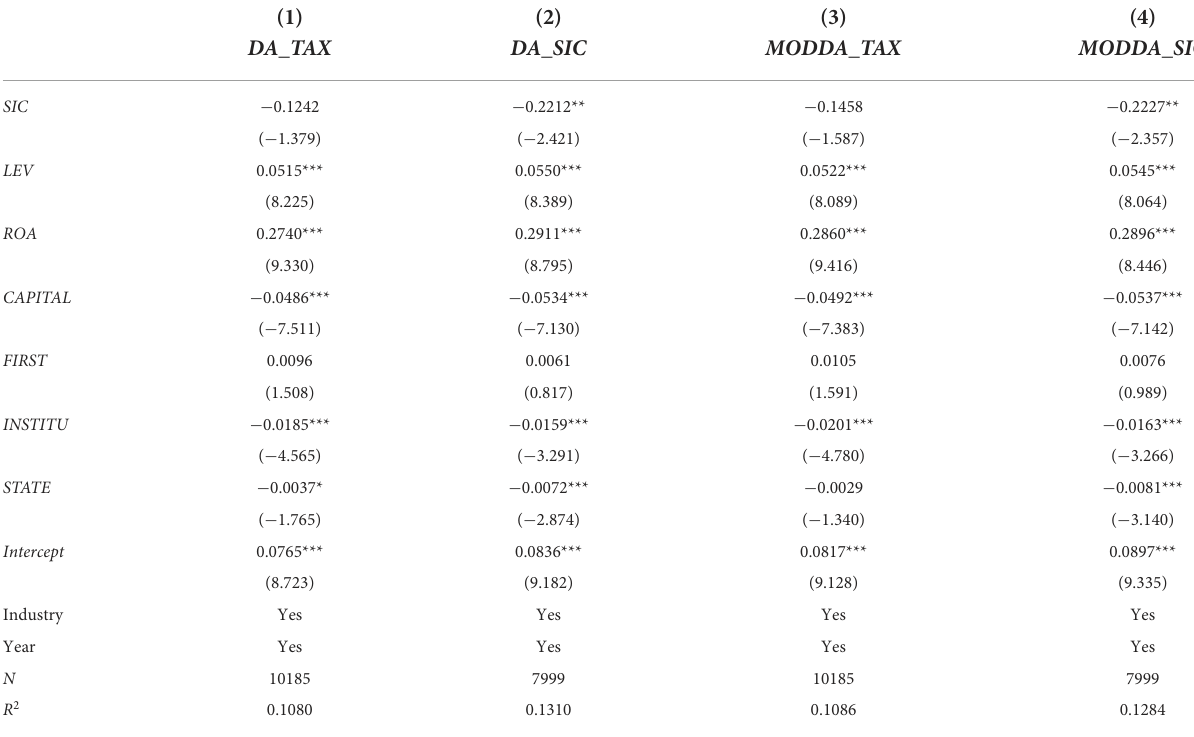
TABLE 13 External corporate governance categorized by collecting